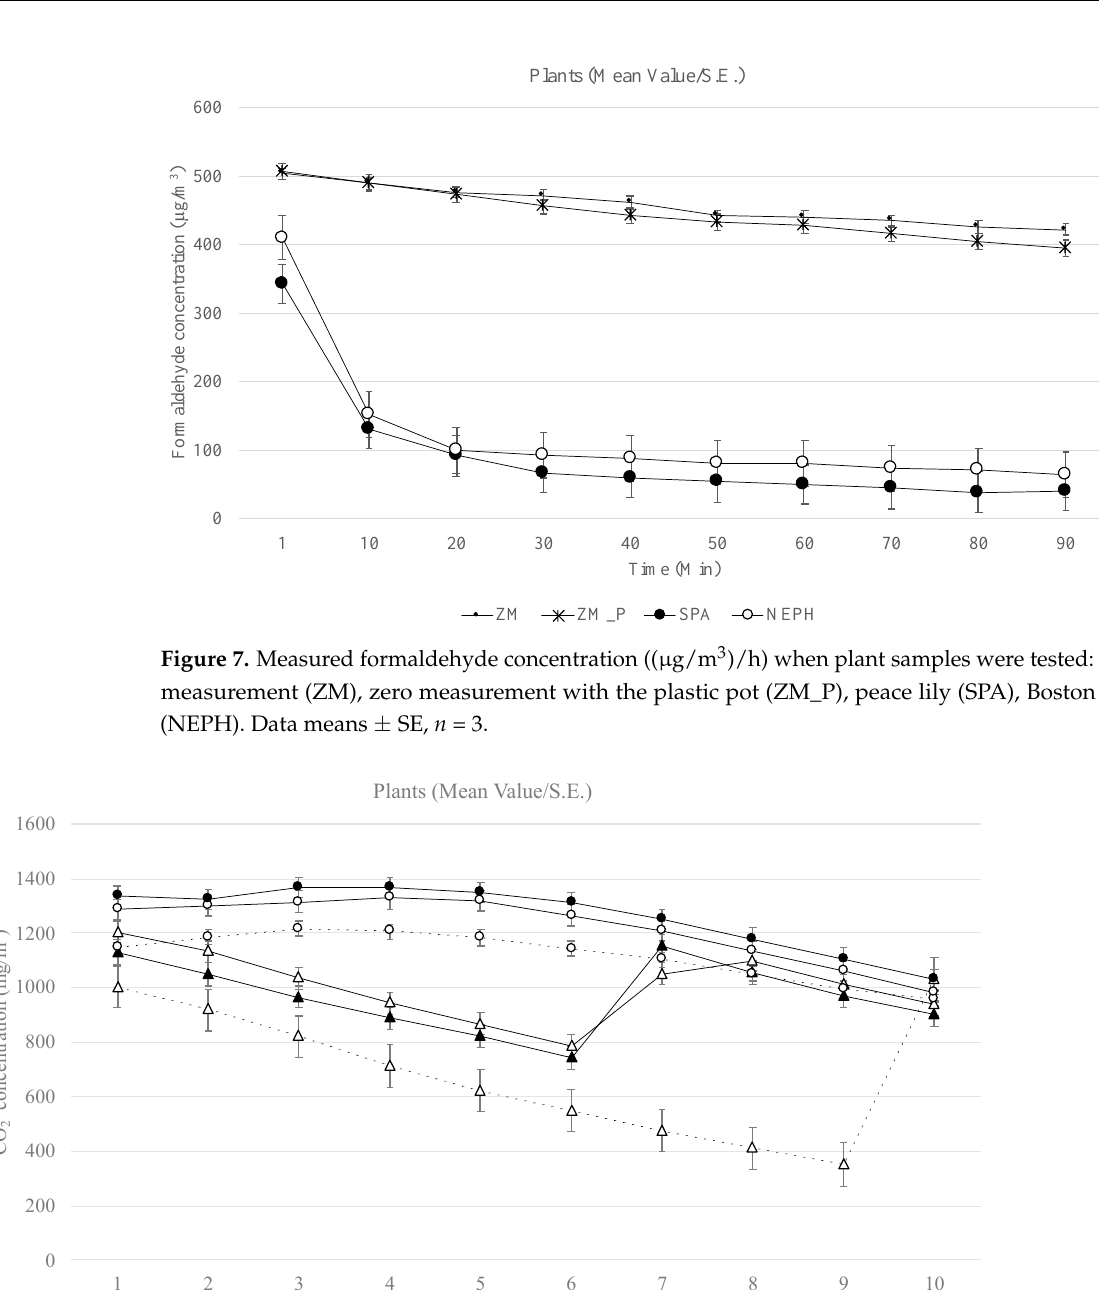
Figure 6. Measured formaldehyde concentration ((µg/m 3 )/h) when activated carbon samples were tested: zero measurement (ZM), zero measurement with the plastic pot (ZM_P), dry activated car- bon (AC_D), wet activated carbon (AC_W). Data means ± SE, n = 3 (AC_D), and n = 2 (AC_W; the third test was excluded). Plants (Mean Value/S.E.)